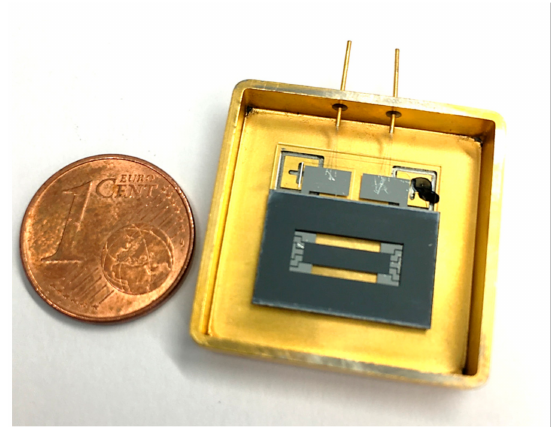
Figure 7. Photo of the MAAM mirror placed in a housing and bonded. The photo was taken without housing lid and glass window.